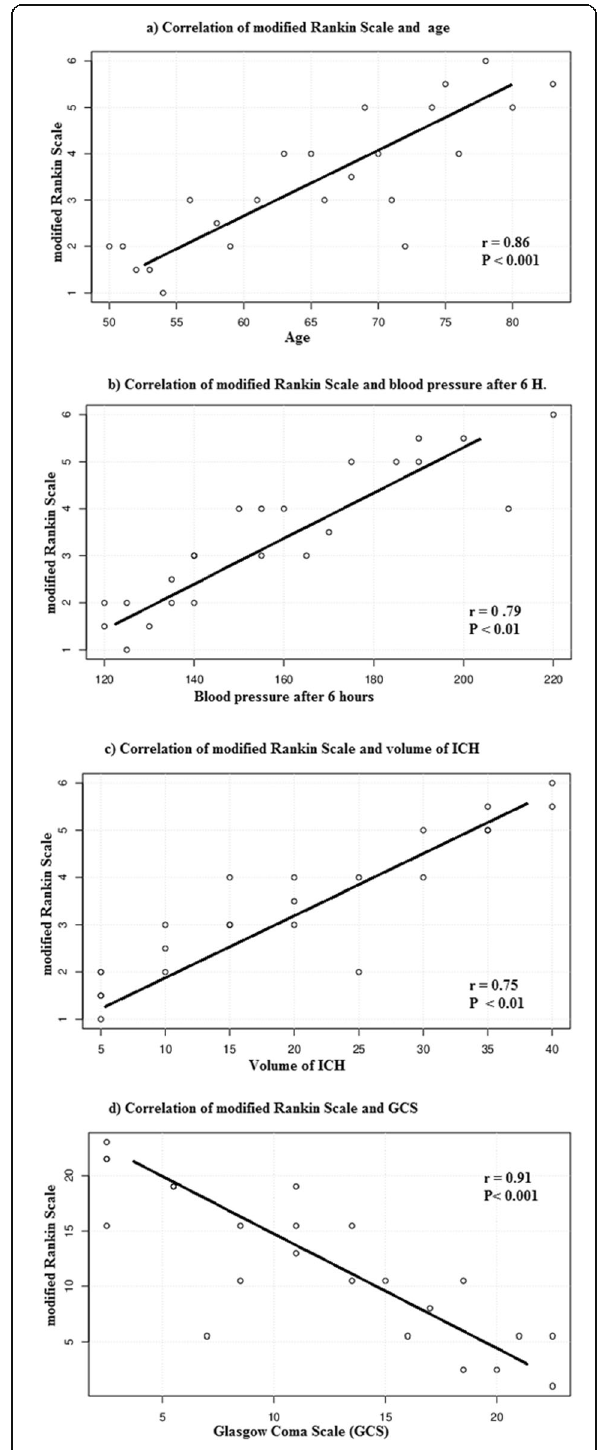
Fig. 3 Correlation of modified Rankin Scale. a Age. b Blood pressure after 6 h. c Volume of ICH. d